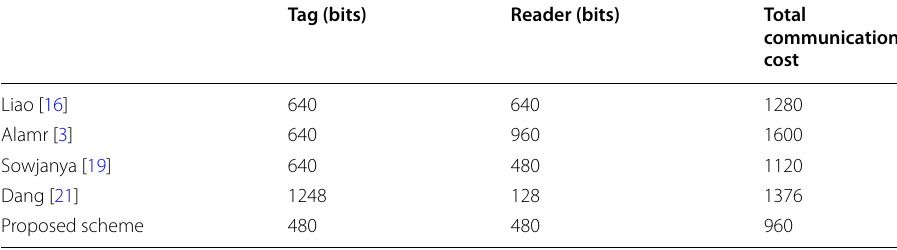
Table 11 Comparison of communication cost among related protocols in authentication